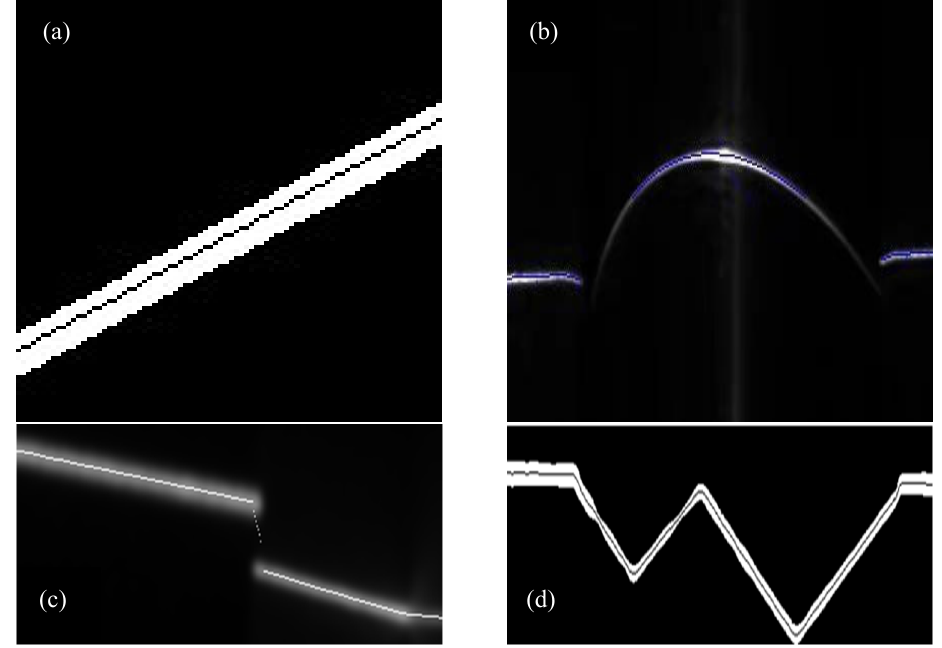
Figure 16. The algorithm in this paper processes the renderings. ( a ) Steel plate surface; ( b ) upper surface of roller; ( c ) paperboard surface; and ( d ) angle steel upper surface.